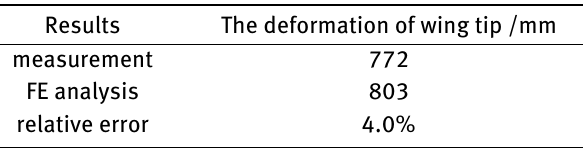
Table 4: The deformation of measurement and FE analysis to the